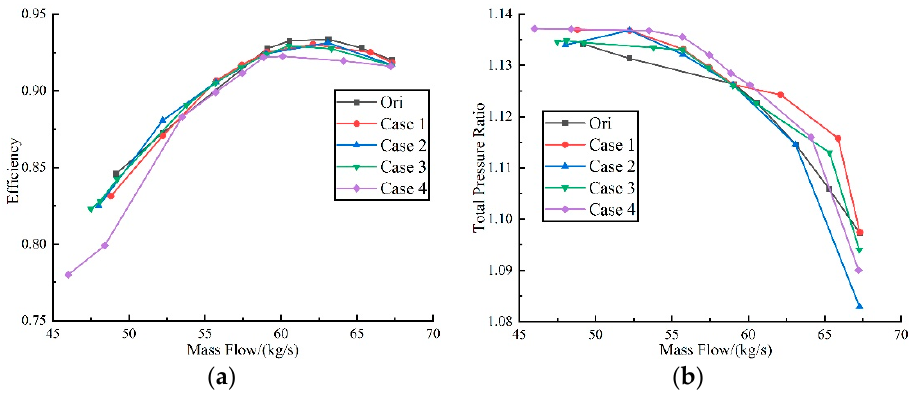
Figure 15. Characteristic lines with different clearances. ( a ) Efficiency; ( b ) total pressure ratio.